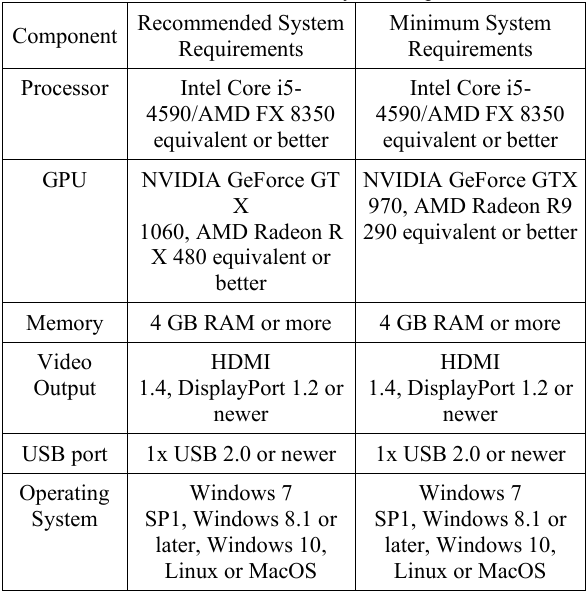
Table 1 . HTC Vive ® minimum system